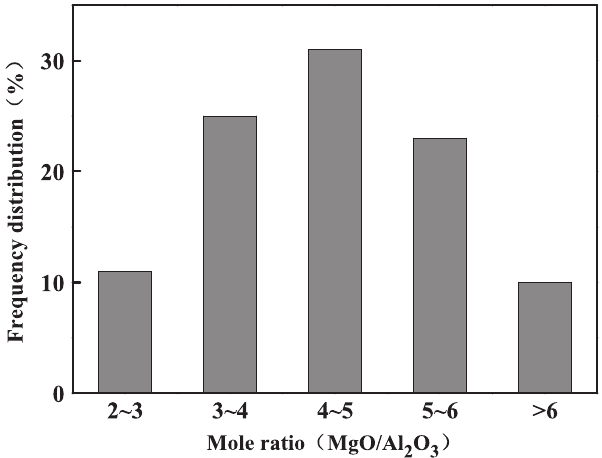
Figure 2: The distribution of central mole ratio (MgO/Al 2 O 3 ) for Mg- bearing